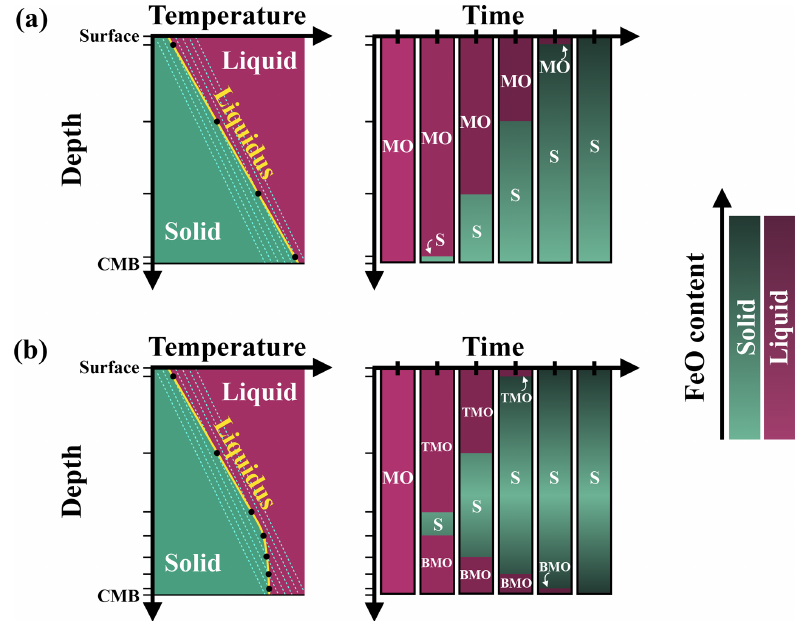
Figure 1. Sketches of magma ocean (MO) crystallisation scenarios. As cooling of the MO proceeds, adiabats (cyan dashed lines) cross the liquidus (yellow curve), and the solid mantle (S) appears, either (a) near the core–mantle boundary (CMB) or (b) somewhere at mid-mantle depths. In panel (b) the MO is divided into a top magma ocean (TMO) and a basal magma ocean (BMO) as soon as the solid appears. In both scenarios, liquid and solid cumulates become enriched in FeO with time, which may lead to an overturn of solid material (not depicted, see text for details). Mush is not